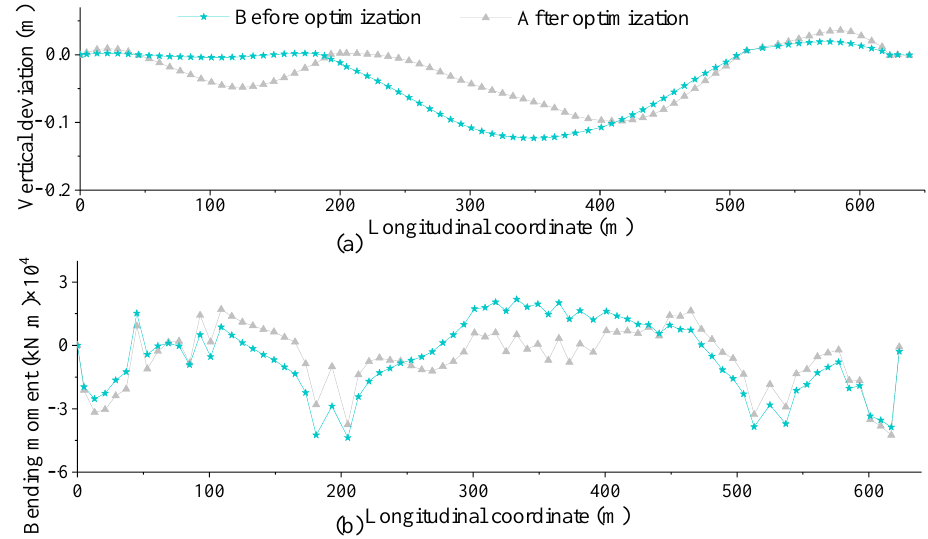
Figure 16. The optimal Pareto set and the optimization scheme. As shown in Figure 16b, the total weight of the pavement load in scheme A is 1.48307 × 10 3 kN, and the maximum difference between the optimized design variables is 11.225 kN. According to Formula (14), the maximum difference of the deck pavement thickness is 0.022 m, which meets the maximum limit (0.025 m) of the specification. The smoothing treatment of the pavement is completed within 4 m to improve the driving comfort. The mechanical performance of the concrete girder is shown in Figure 17. As shown in Figure 17a, the maximum vertical deviations of the midspan before and after optimization are 12.30 cm and 9.81 cm, respectively. As shown in Figure 17b, the maximum positive bending moments of the concrete girder before and after optimization are 2.183 × 10 4 kN · m and 1.702 × 10 4 kN · m, respectively. The maximum negative bending moments of the concrete girder before and after optimization are − 4.375 × 10 4 kN · m and − 4.251 × 10 4 kN · m, respectively. Hence, scheme A can slightly improve the mechanical performance of the concrete girder.